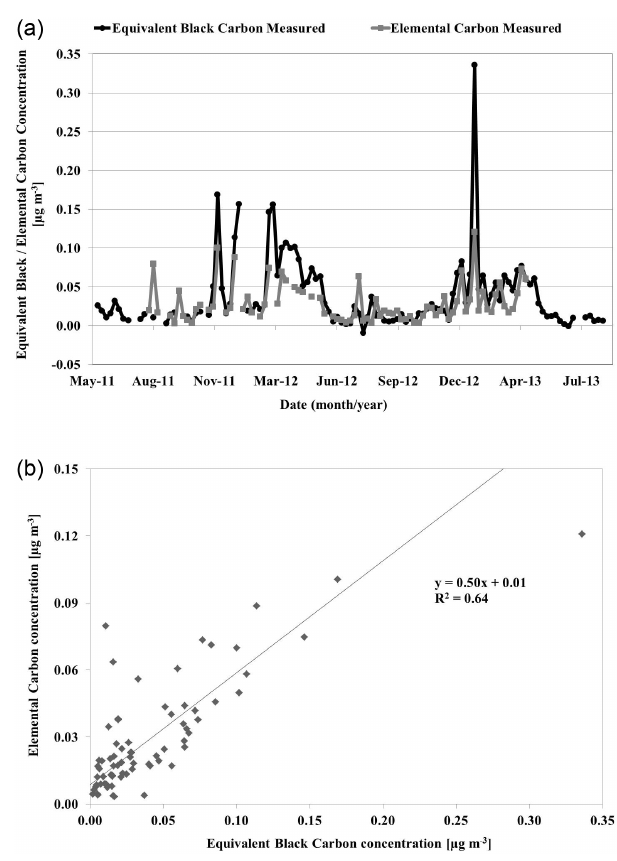
Figure 1. (a) Weekly measured EBC and EC concentrations in µgm − 3 from May 2011 to August 2013 at VRS (Station Nord), North Greenland. Both EBC and EC show the same seasonal vari- ation with maximum concentrations in winter and spring and mini- mum concentrations in summer, (b) scatter plot of measured EC and EBC concentrations (the slope obtained by orthogonal regression is y = 0.50 showing a correlation coefficient of R 2 =